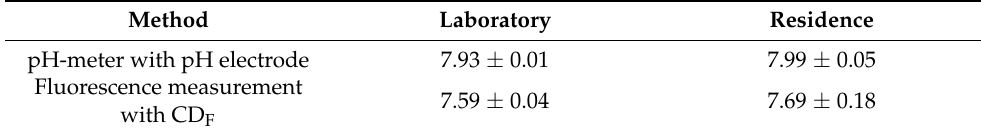
Table 1. Determination of pH in real water samples (pH ± standard deviation) by using either a standard pH-meter with a pH electrode or by measurement of the fluorescence intensity of CD F .